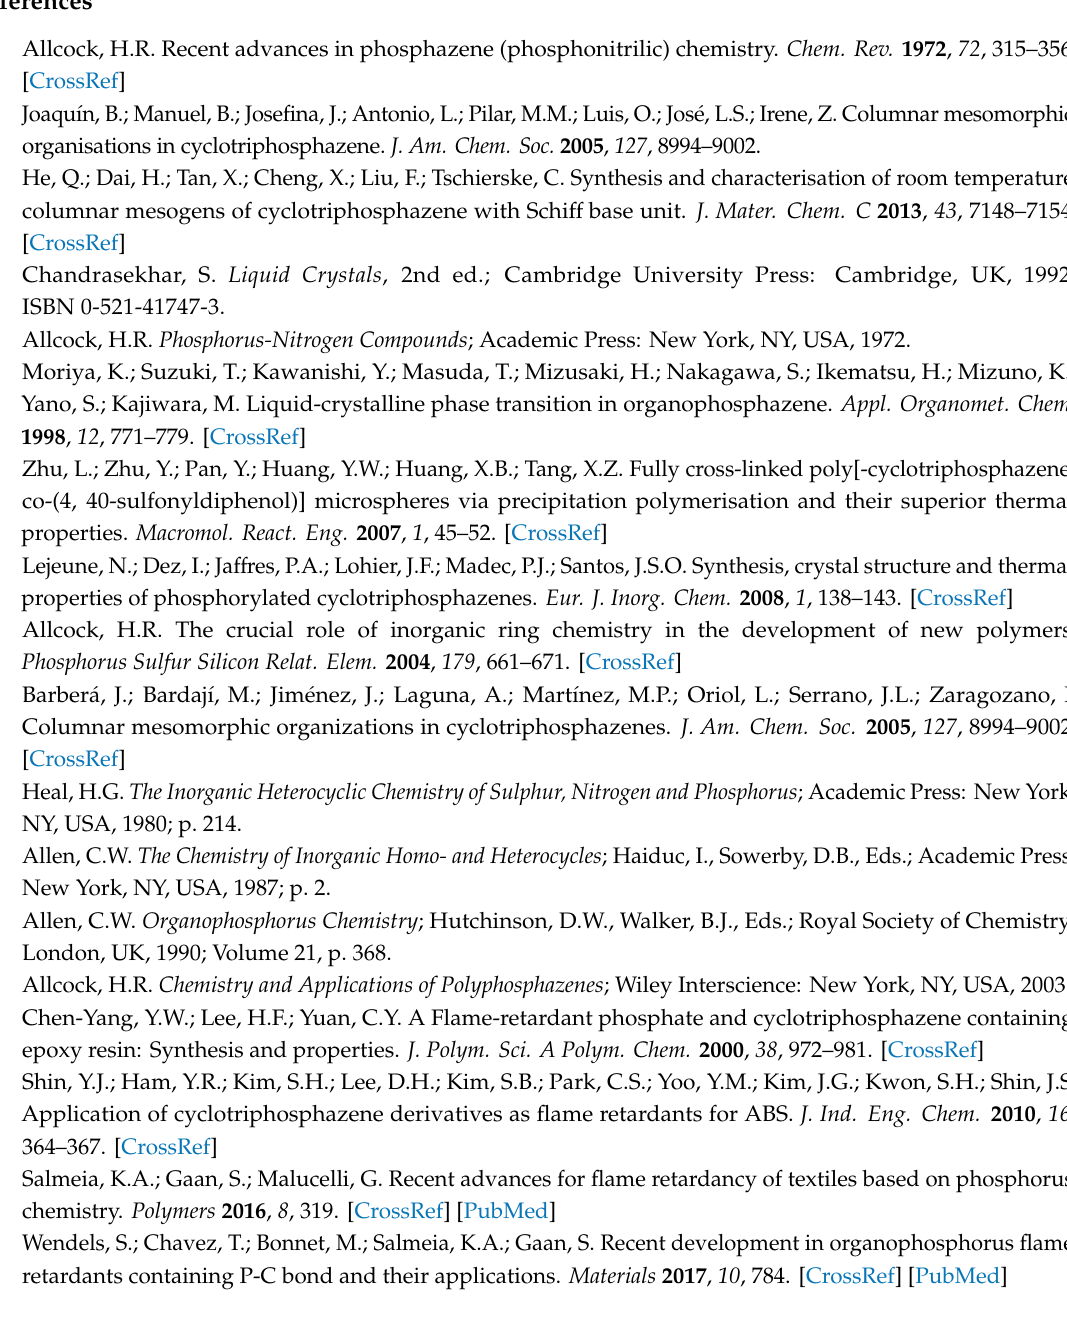
Supplementary Materials: The following are available online, Figure S1–S9: DSC thermogram of compounds 4 a – i ,